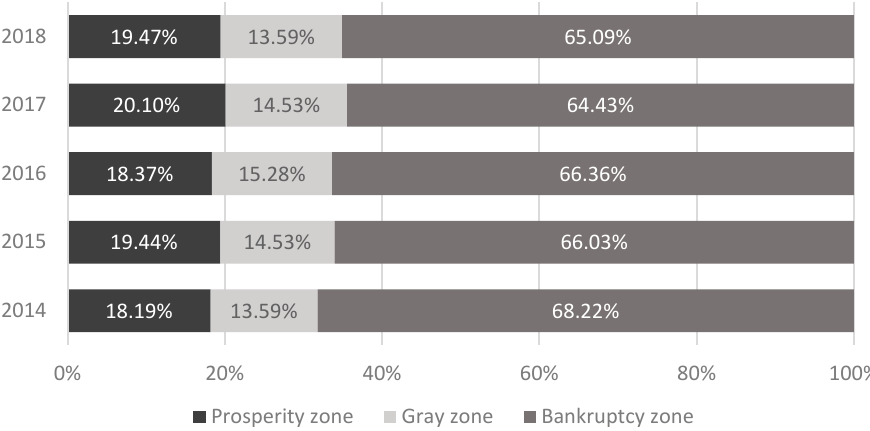
Figure 8. Financial performance of businesses with a negative equity based on IN05 index.